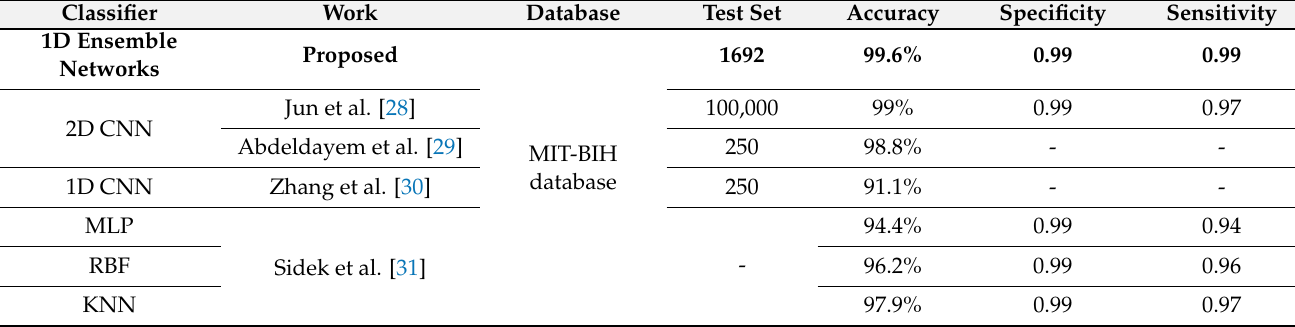
Table 5. Comparison of recognition performance with previous studied using MIT-BIH